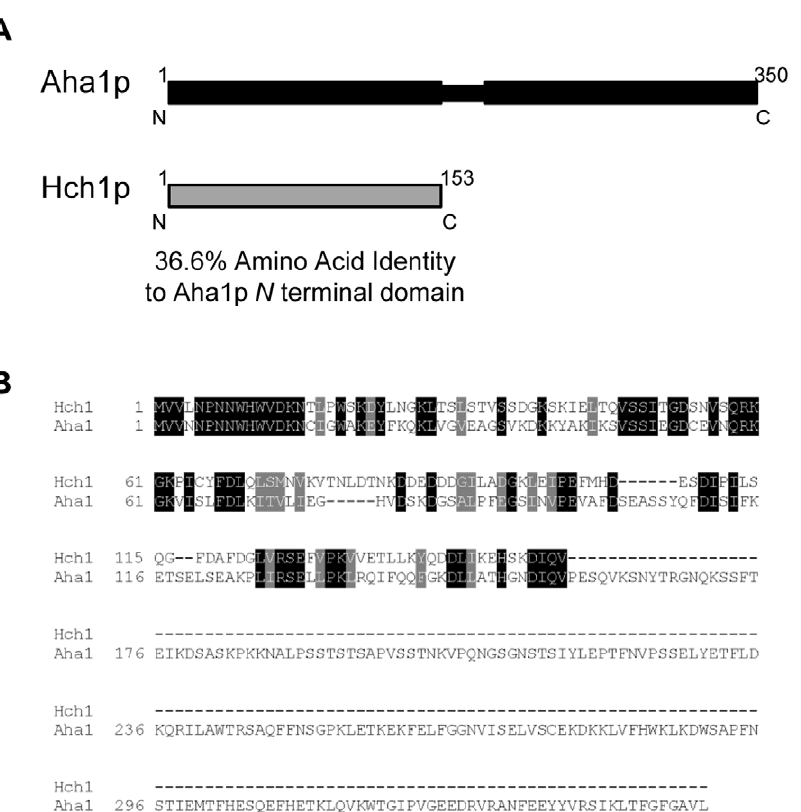
Figure 1. Structure and sequence of Aha1p and Hch1p. A. Domain structure of the 350 amino acid Aha1p and the 153 amino acid Hch1p. B. Alignment of Aha1p and Hch1p.